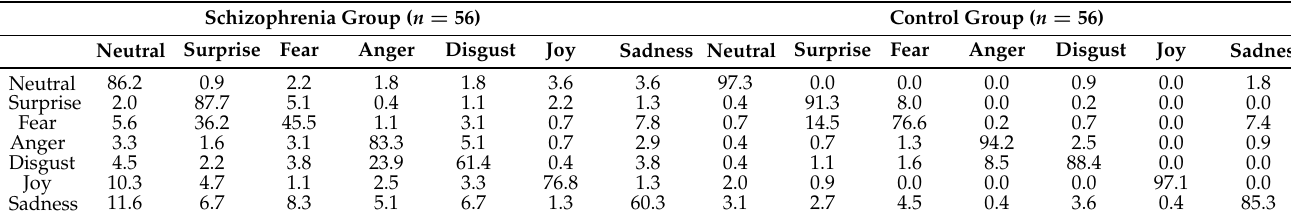
Table 3. Emotion recognition scores (%) for each emotion depicted for the schizophrenia group and healthy controls.